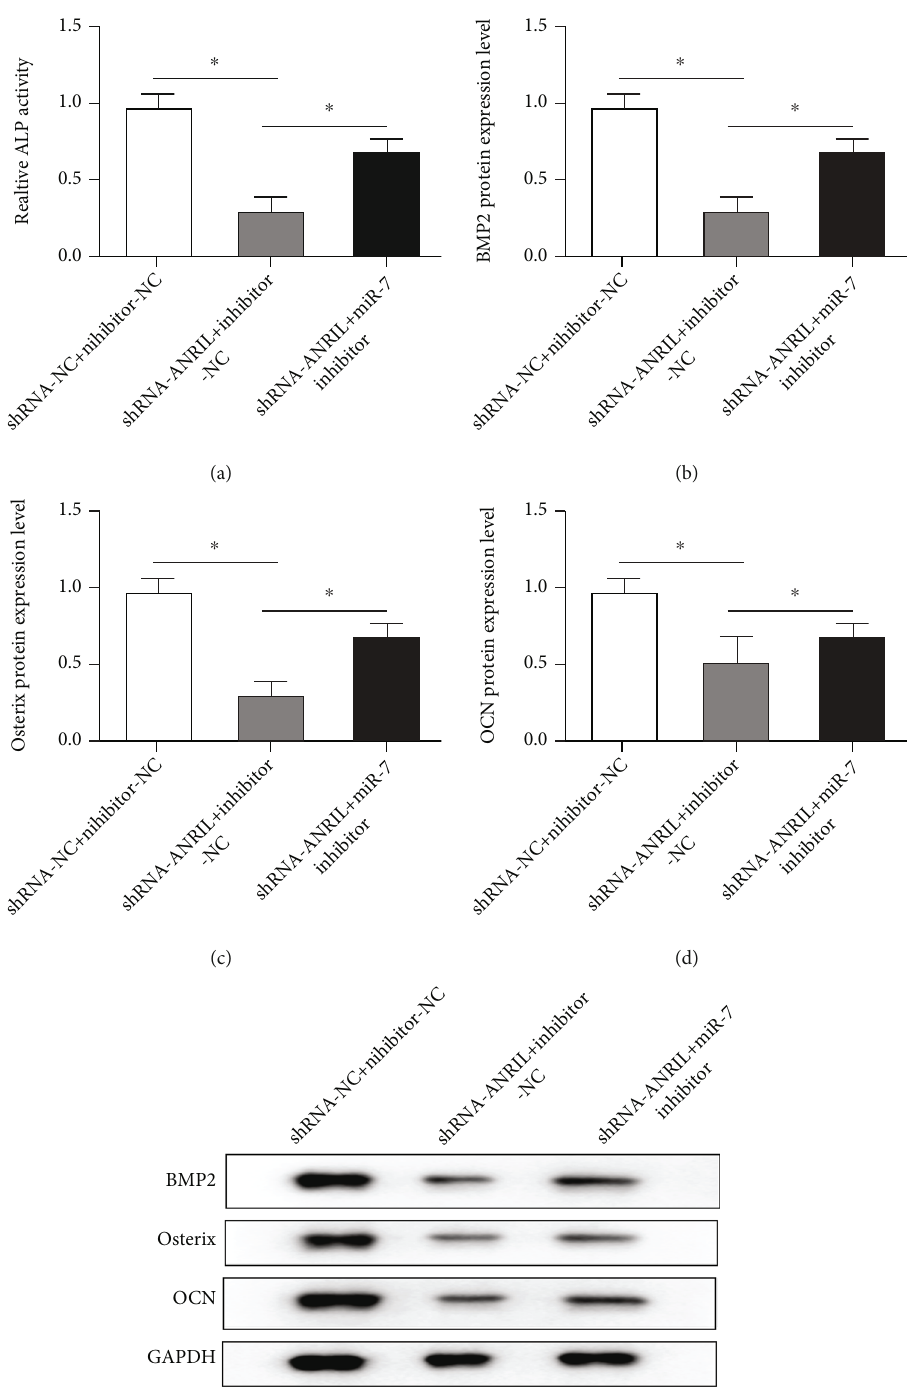
Figure 7: ANRIL knockdown suppresses osteogenic di ff erentiation of PDLCs via regulating miR-7. (a) ALP activity was tested in PDLCs after transfection of shRNA-ANRIL-2 and miR-7 inhibitor. Gray analysis for Western blot of (b) BMP2, (c) Osterix, and (d) OCN protein levels. (e) The protein levels were assessed by Western blot. ∗ P < 0 : 05